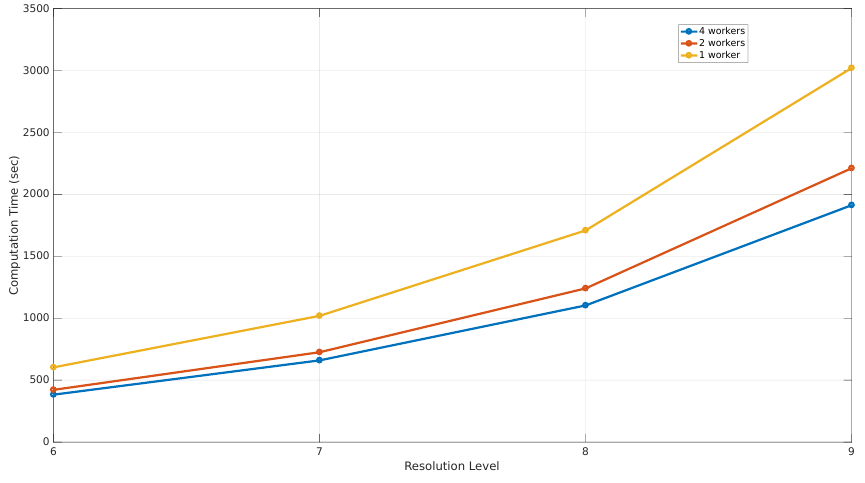
Figure 30. The performance of a simulation where 2700 rays are launched with different resolution